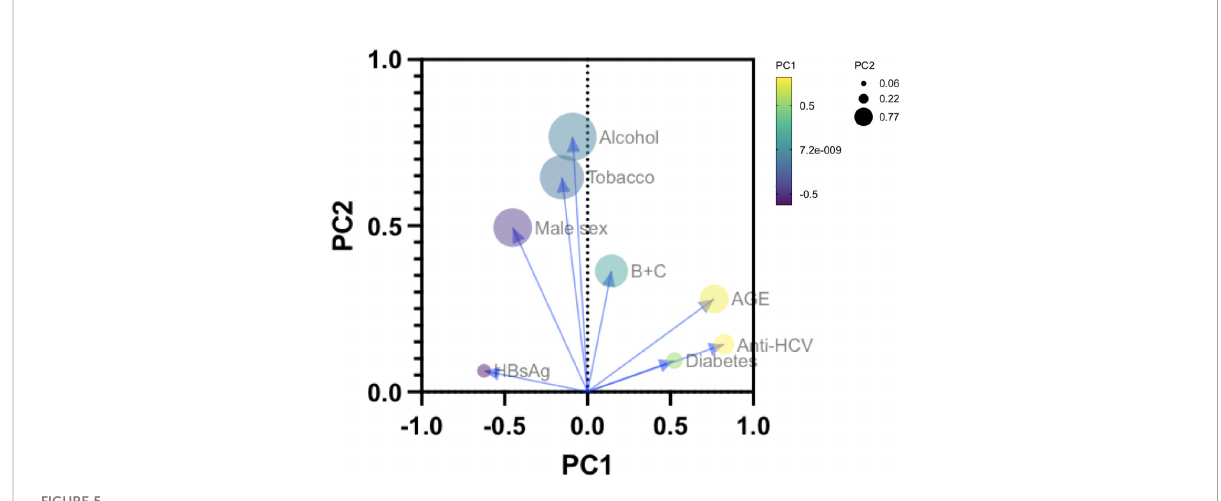
FIGURE 5 Principal Component Analysis (PCA) describing the interactions of age, sexes, and the principal risk factors (HBsAg, anti-HCV, alcohol consumption, tobacco use and diabetes) of LC (n=134) and HCC (n=74) in